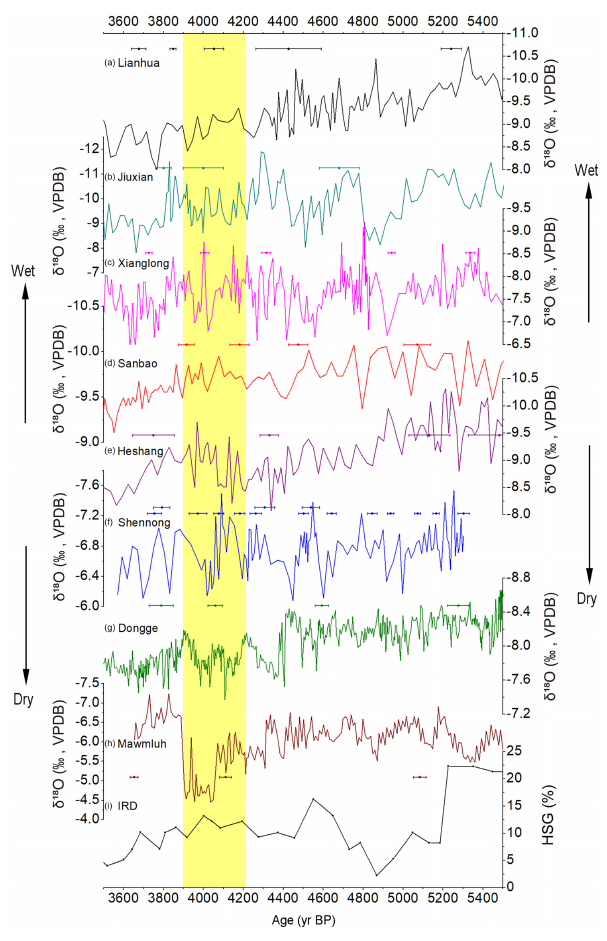
Figure 7. Comparison of δ 18 O records from (a) Lianhua Cave (Dong et al., 2015), (b) Jiuxian Cave (Cai et al., 2010), (c) Xi- anglong Cave (Tan et al., 2018a), (d) Sanbao Cave (Dong et al., 2010), (e) Heshang Cave (Hu et al., 2008), (f) Shennong Cave (this study), (g) Dongge Cave (Wang et al., 2005), (h) Mawmluh Cave (Berkelhammer et al., 2012) and the ice-rafted hematite-stained grain (HSG) record from the North Atlantic (Bond et al., 2001). 230 Th dates and error bars are illustrated with different colors for each stalagmite. The yellow bar marks the dry interval in northern and southwestern China and the wet interval in central and south- eastern China during the 4.2kaBP event (4.2–3.9kaBP).